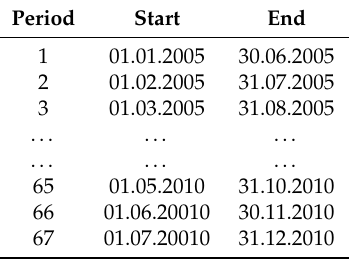
Table 1. Periods ID’s and their starting and ending